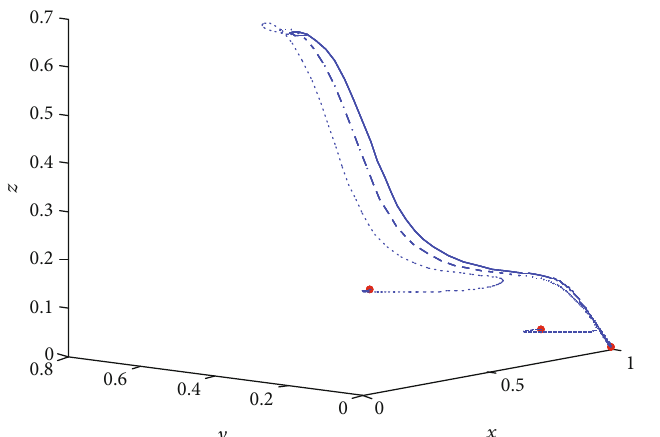
= 0 : 01, 0 : 15, and 0 : 25 , those represented by 9